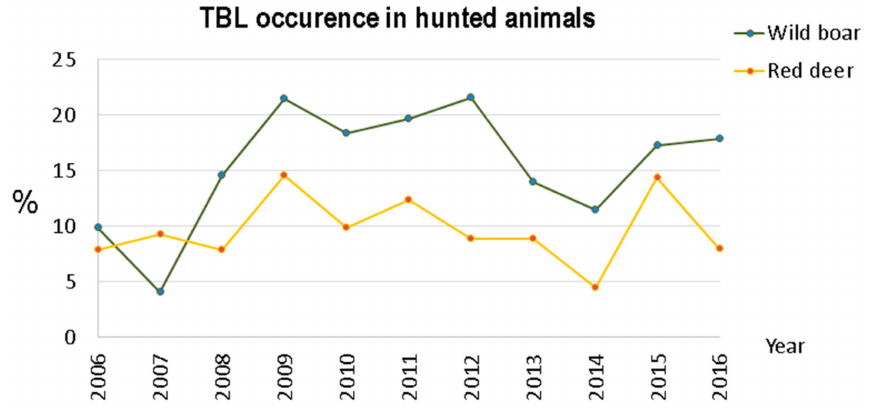
Figure 4. TBL occurrence in the hunting bags within Idanha-a-Nova county from 2006 to 2016.